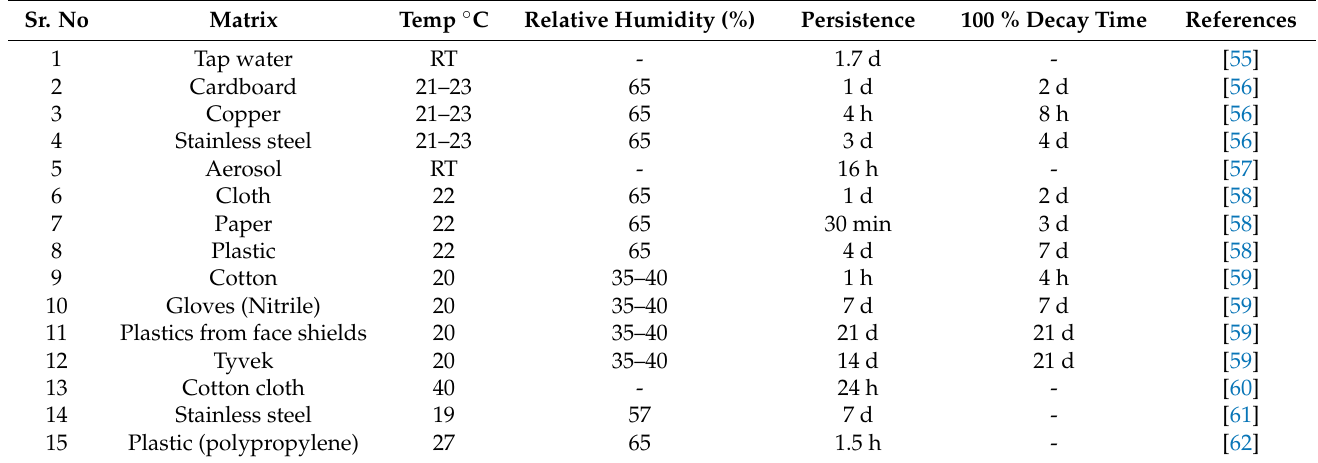
Table 2. Persistence of SARS-CoV-2 in/on different environmental matrices [54].